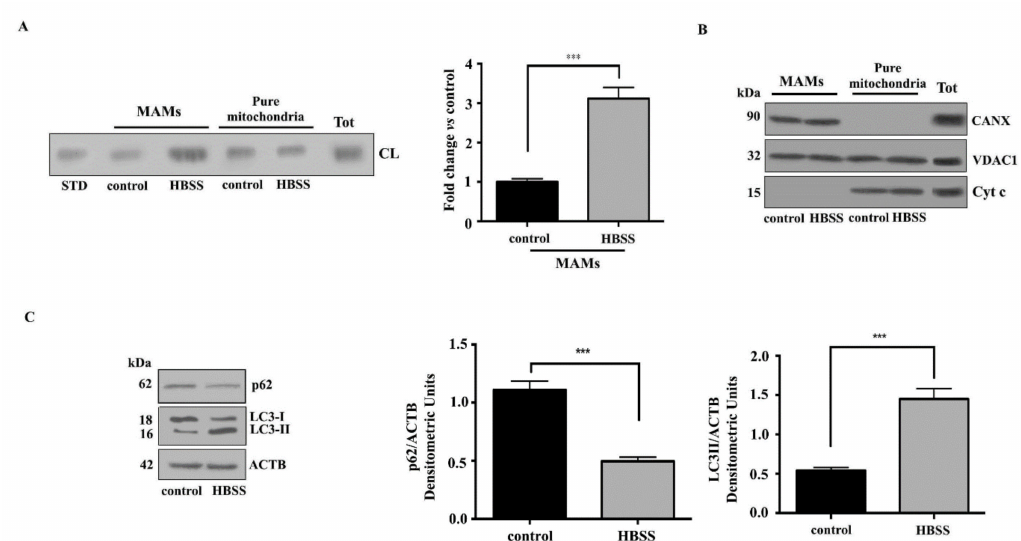
Figure 1. Cardiolipin translocates to MAM subdomains during autophagy. ( A ) Isolated MAMs and pure mitochondria fractions obtained from human 2FTGH (2F) fibroblasts cells, untreated or treated with HBSS for 1 h at 37 ◦ C were subjected to phospholipid extraction. All fractions were run on HPLC plates and analyzed by HPTLC immunostaining for the presence of CL using anti-CL as described in Materials and Methods. A positive control was obtained using pure standard CL (STD, Sigma-Aldrich). ( B ) The purity of MAMs and pure mitochondria fractions was also tested by Western blotting for the presence of specific markers: CANX for MAMs or VDAC1 for mitochondria and MAMs, Cytc for mitochondria. ( C ) Autophagy was checked by Western blot analysis, using rabbit anti-LC3 PAb or rabbit anti-p62/SQSTM1 pAb. Loading control was evaluated using anti-ACTB Mab. A representative experiment among 3 is shown. Bar graph on the right shows densitometric analysis. Results represent the mean ± SD from 3 independent experiments. *** p ≤ 0.001, HBSS vs. control